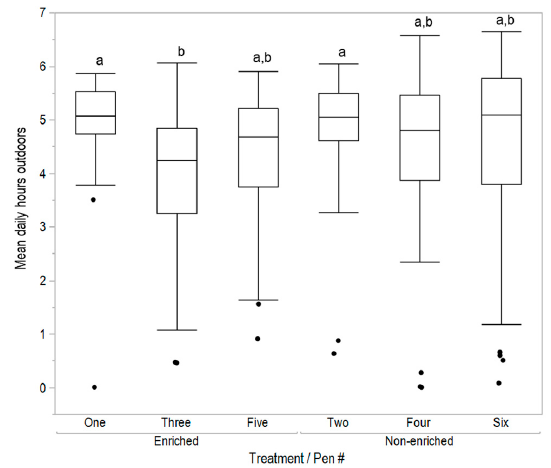
Figure 3. The mean number of hours spent outdoors by hens in each pen within the early rearing treatments (enriched, non-enriched). Data were from 36 to 38 weeks of age; dissimilar letters indicate differences between pens within treatments ( p < 0.008).